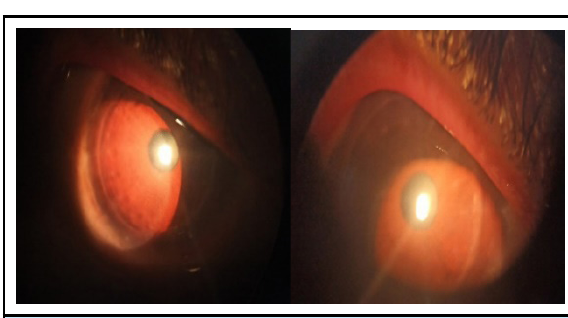
Figure 1. On examination-RE VA 20/80 with graft clear and No congestion and KPs.